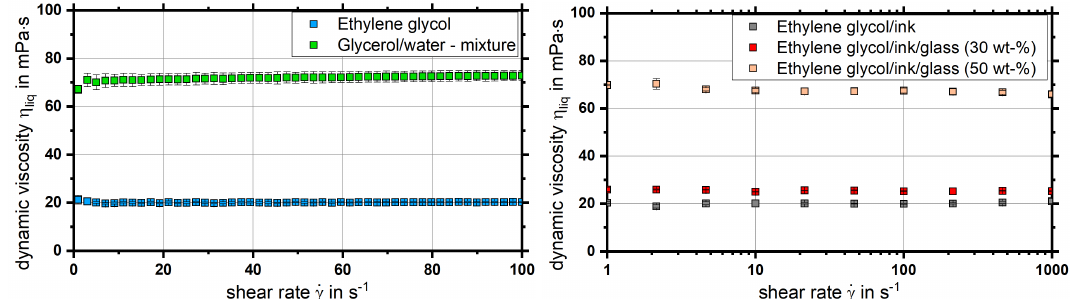
Figure 5. Viscosity measurement of ethylene glycol and a glycerol/water-mixture with a linear shear rate increment applied (left); Viscosity measurement of the suspensions ethylene glycol/ink, ethylene glycol/ink/glass (30 wt-%) and ethylene glycol/ink/glass (50 wt-%) with a logarithmic shear rate increment applied